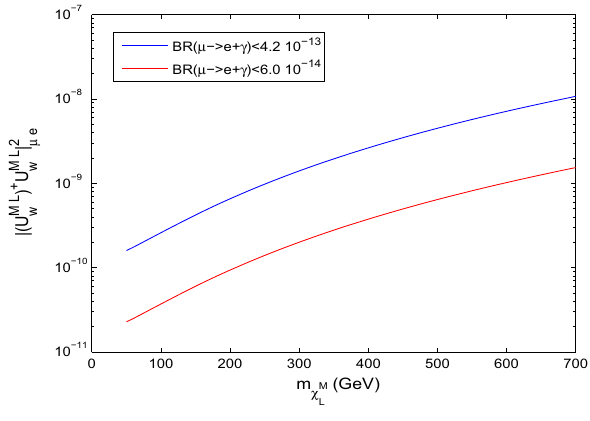
(cid:21) (cid:20) U ML † U ML by μ → e γ decay from current W W e μ